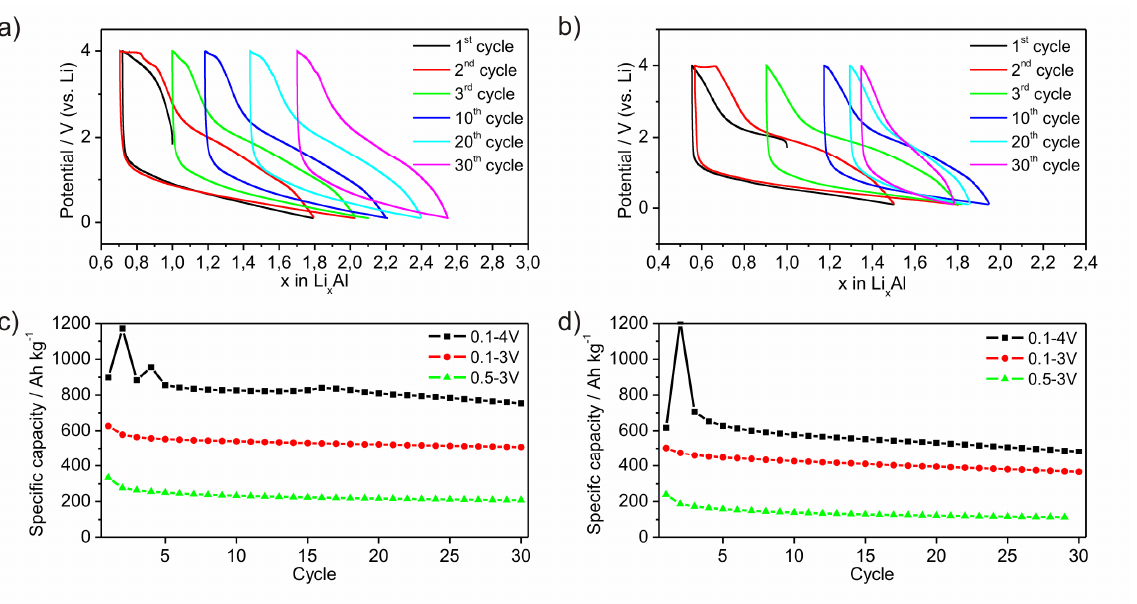
Li Ni Y powders P1 ( a ) and 43 43 8 6